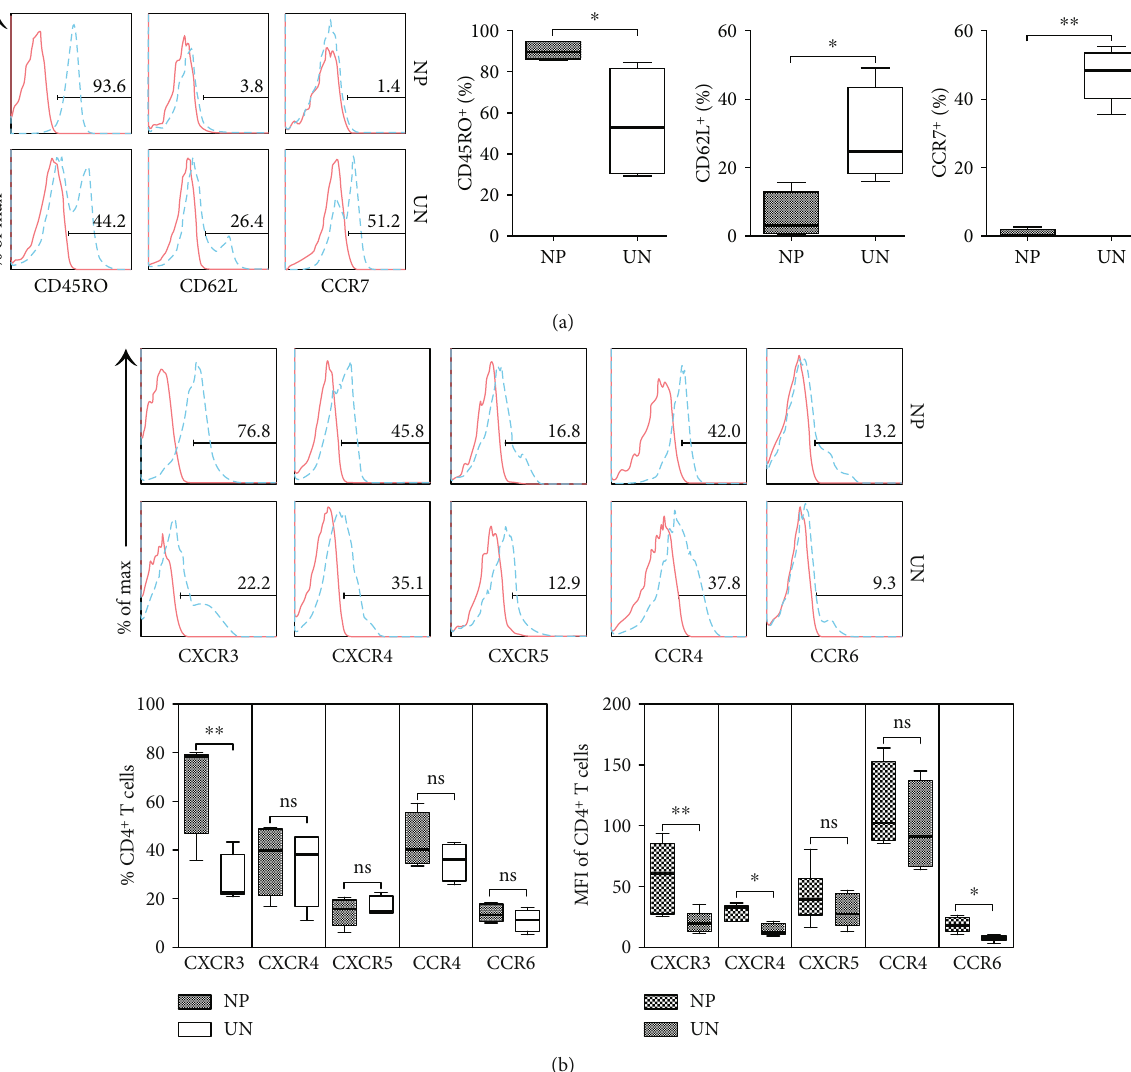
Figure 4: The phenotype of CD4 + L-17 + IFN- γ + T cells from NP tissues. (a, b) Representative FACS graphs and summary data showed the expression of CD69 and CD25 on CD3 + T cells of NP ( n = 12 ) and uncinate ( n = 9 ) tissues. (c, d) Representative FACS graphs and summary data showed the expression of CD45RO, CD62L, and CCR7 on CD3 + T cells of NP ( n = 12 ) and uncinate ( n = 9 ) tissues. Data were shown as the mean ± SEM . Statistical signi fi cance was determined with the Mann – Whitney test. ∗ p < 0 : 05 ; ∗∗ p < 0 : 01 ; ns: no signi fi cance; NP: nasal polyp; UN: